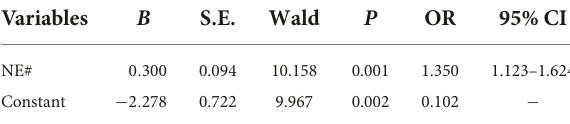
model accurately distinguishes fetuses with enlarged